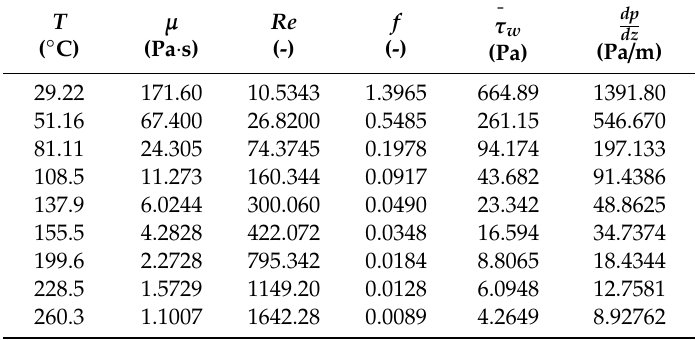
Table 8. Values of the fluid dynamic parameters obtained in the simulations with β = 0.06 and N = 8.